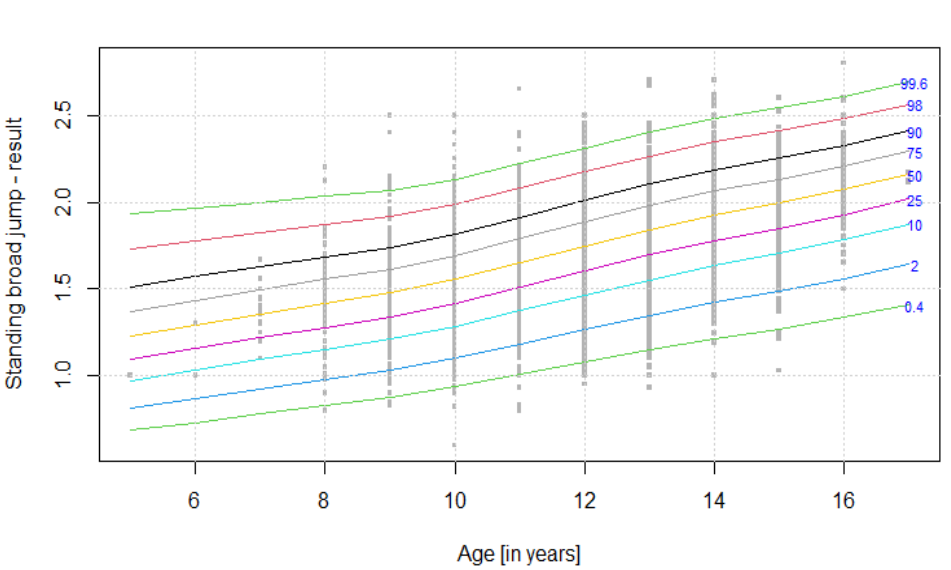
Figure 4. Centile chart for standing broad jump in girls. Table 7. Values of particular centiles for standing broad jump in girls.